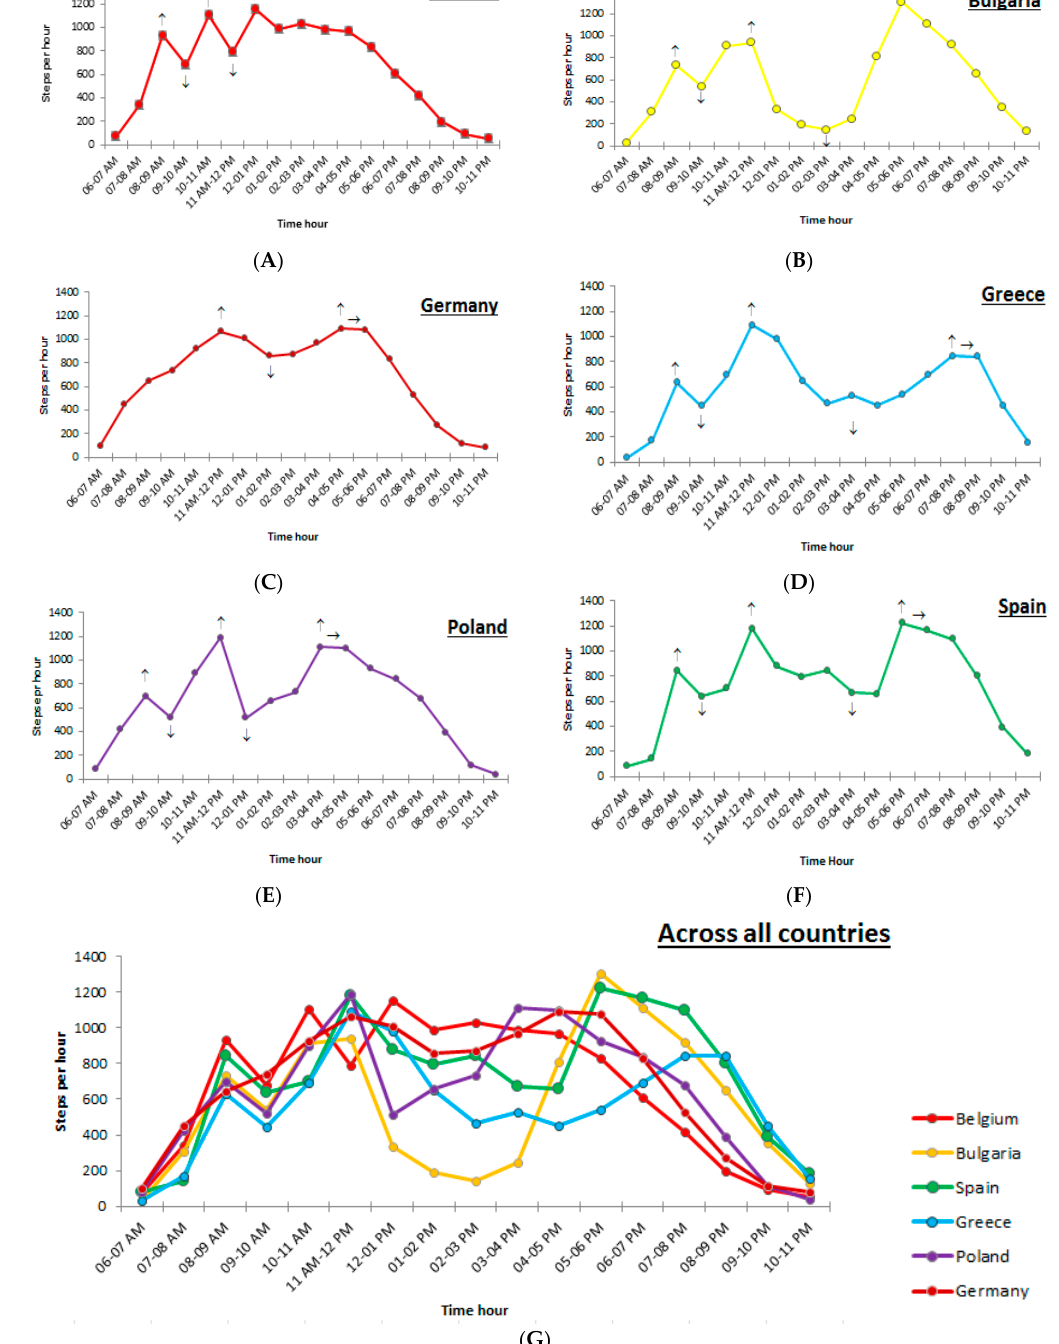
Figure 1. ( A ) Preschoolers’ step count patterns during weekdays in Belgium; ( B ) preschoolers’ step count patterns during weekdays in Bulgaria; ( C ) preschoolers’ step count patterns during weekdays in Germany; ( D ) preschoolers’ step count patterns during weekdays in Greece; ( E ) preschoolers’ step count patterns during weekdays in Poland; ( F ) preschoolers’ step count patterns during weekdays in Spain; and ( G ) preschoolers’ step count patterns during weekdays across all participating countries.